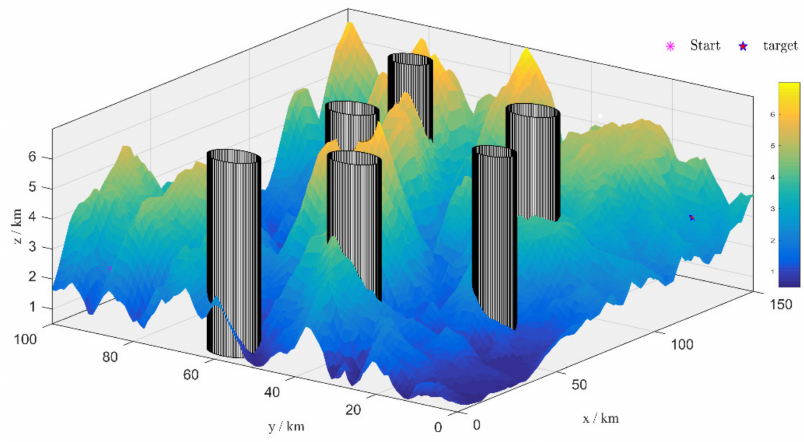
Figure 8. The scene of the 3d UAV route planning